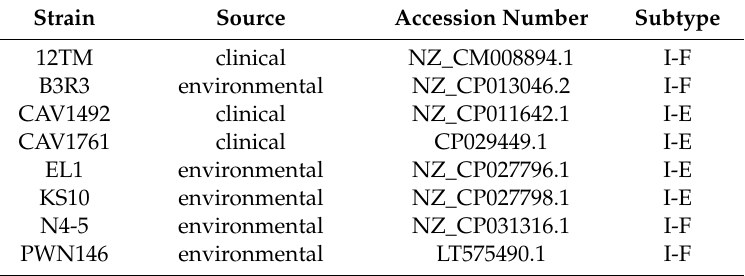
Table3. CRISPRsubtypesidentifiedincompletegenomesof S.marcescens